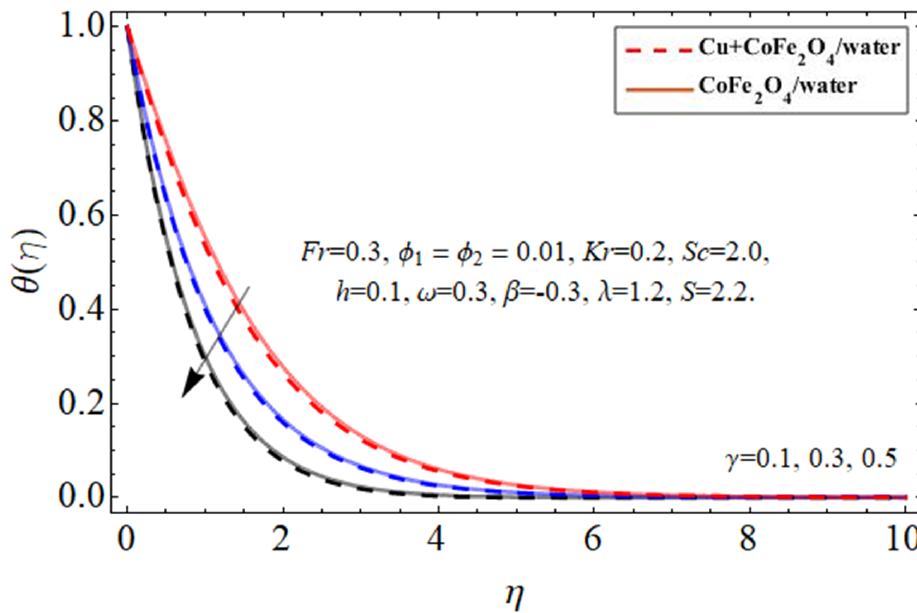
( ) θ η ( ) θ η field against the thermal energy ratio coefficient . field against the thermal energy ratio coefficient .